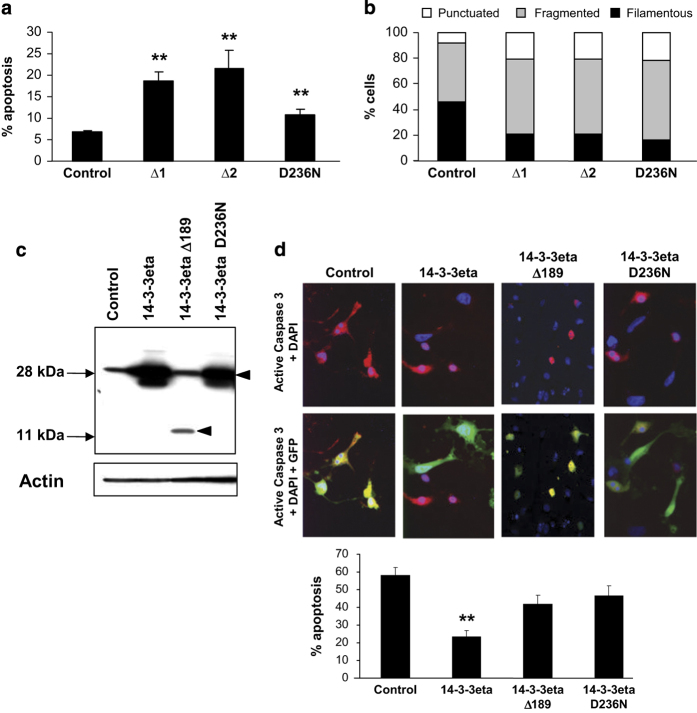
Impact of YWHAH variants in human fibroblasts. Fibroblasts from patients (family 1: the father ∆1 and his son ∆2, family 2: D236N) were compared in all experiments with three control fibroblast cultures obtained from healthy patients. (a) Susceptibility to apoptosis was assessed by counting apoptotic nuclei after a 3-h staurosporine treatment (1 μM; n=3). (b) Mitochondrial network structure was assessed on exponential growing cultures after Mitotracker staining. Filamentous, fragmented and punctuated phenotypes were counted on 200 cells in 3 independent experiments. Data are mean±S.E.M. (c) HeLa cells were transiently transfected with pIRES-EGFP vectors expressing 14-3-3eta, 14-3-3eta ∆189 and 14-3-3eta D236N. Western blotting of total cell lysate showing the expression of the different proteins (arrows). Actin was used as a loading control. (d) In a parallel experiment, HeLa cells were treated with 1 μM staurosporine for 3 h before the quantification of apoptotic cells. Apoptosis was assessed by immunofluorescent detection (top) of the active form of caspase-3 (red fluorescence) in transfected cells (green fluorescence). All cells were stained with the nuclear marker Hoechst. Scale bar represents 20 μm. Quantification of apoptosis in transfected cells (bottom), each point representing the average of triplicate±S.E.M.